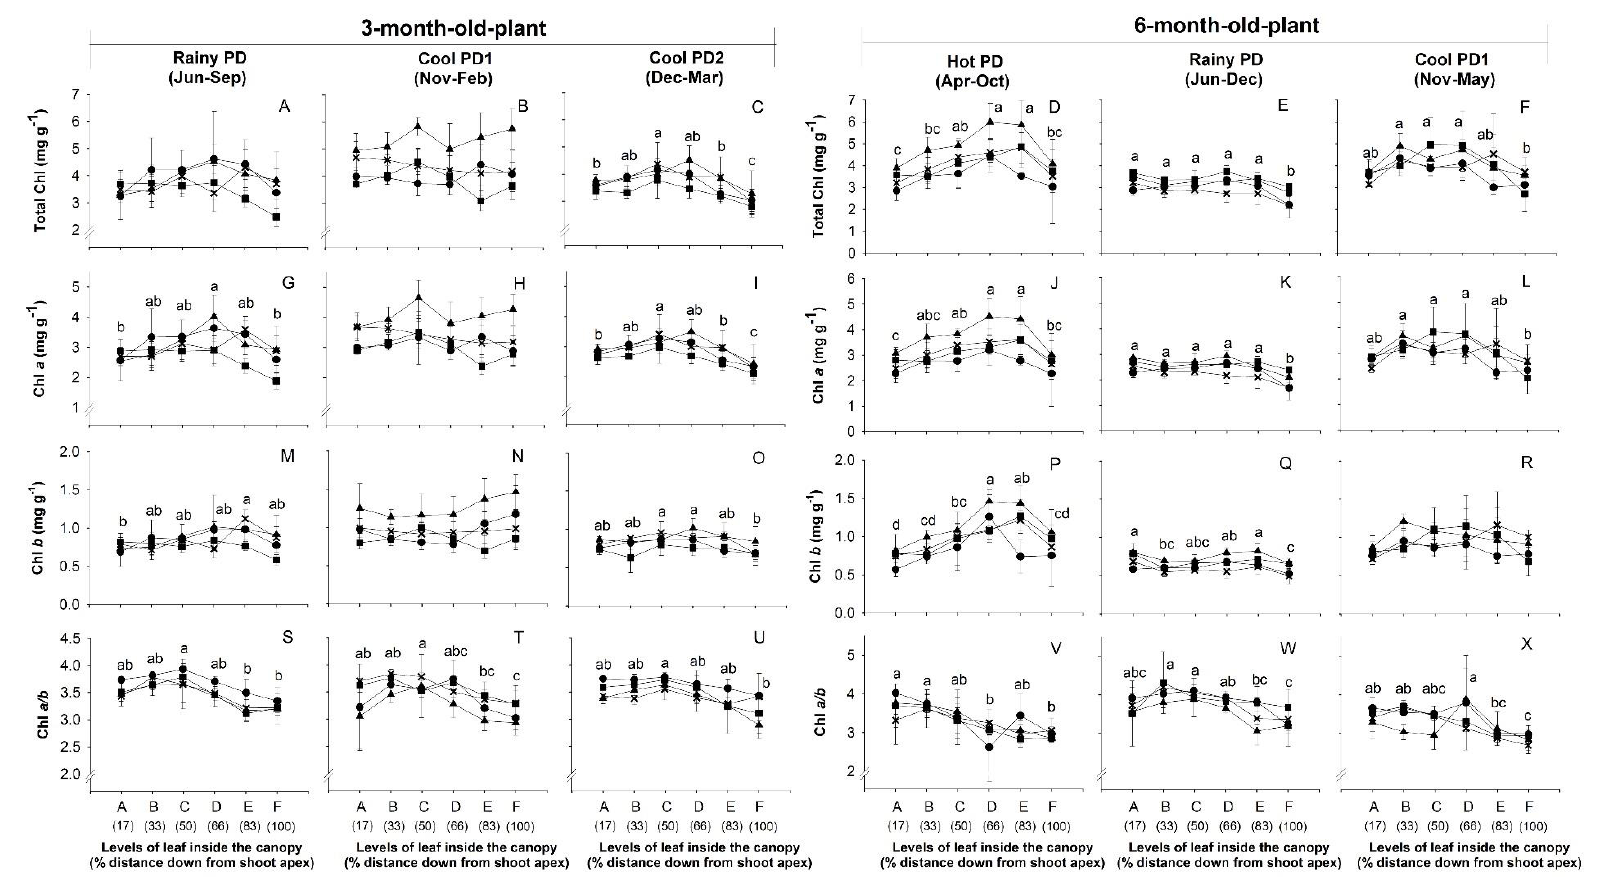
Figure 6. Chlorophyll (Chl) content parameters including total Chl ( A – F ), Chl a ( G – L ), Chl b ( M – R ), and Chl a / b ( S – X ) of cassava leaves at the six canopy levels ( A to F ) of the 3- and 6-month-old plants. Four cassava genotypes including Rayong 9 (RY9; ), Rayong 11 (RY11; ), Kasetsart 50 (KU50; ), and CMR38-125-77 ( ) were planted in April ( Hot PD ), June (Rainy PD), November (Cool PD1), and December (Cool PD2) in 2015. Means across genotypes that were significantly different ( p < 0.05) among levels are denoted by lower case letters.